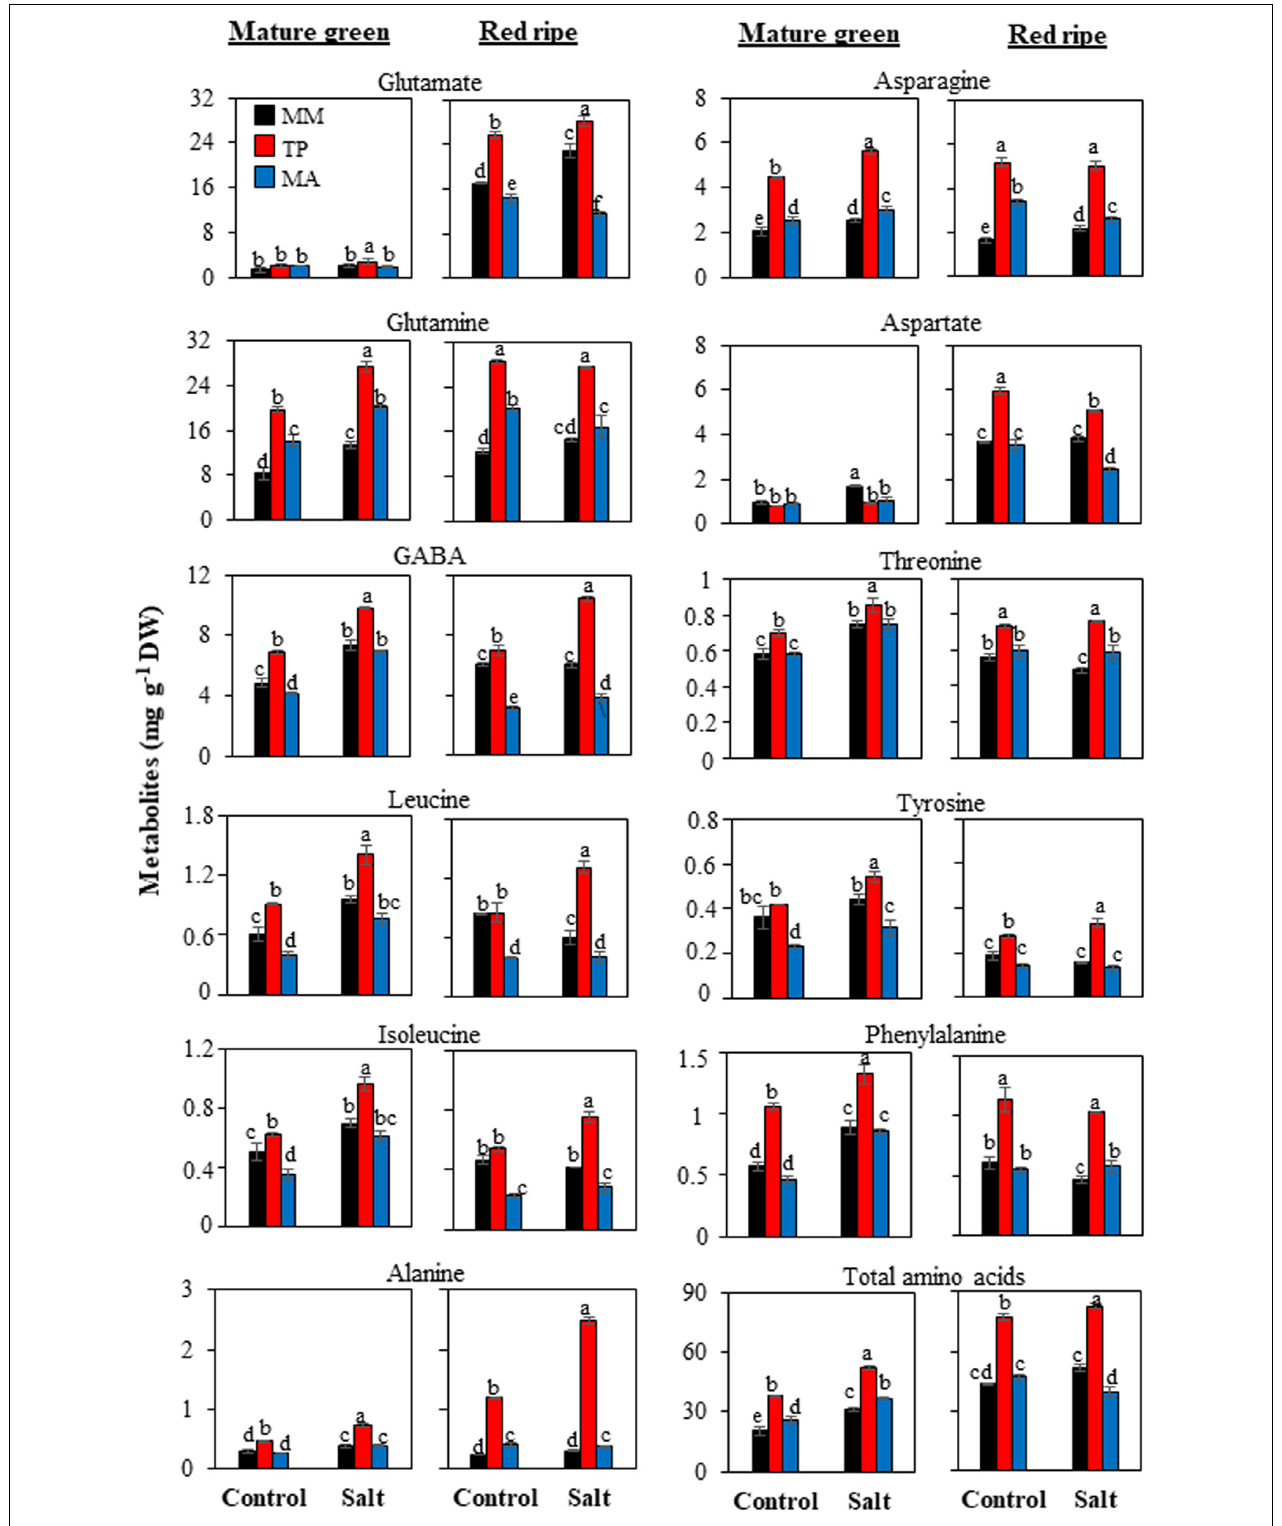
FIGURE 4 | Accumulation of amino acids in mature green and red ripe fruits of “Moneymaker” (MM) and two traditional varieties, “Tomate Pimiento” (TP) and “Muchamiel Aperado” (MA), from plants grown in control and salt (50 mM NaCl). Three biological replicates of 10 fruits each were used. Values are expressed as means ± SE. Different letters indicate statistically significant differences according to Tukey’s test ( p < 0.05).